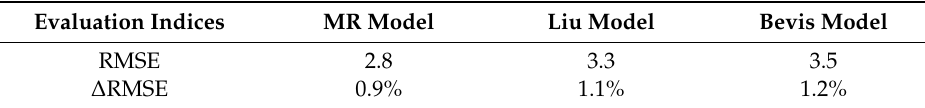
Figure 7. Comparison of the T m time series obtained from the numerical integration method (by using radiosonde data), the MR model, Liu model, and Bevis model for the period from DOY 1 to DOY 180, 2017. The radiosonde station acquired data at 00Z and 12Z UTC on each day. Table 5. RMSE and ∆ RMSE between T m results of the MR, Liu and Bevis models from radiosonde during test time (Unit: K).